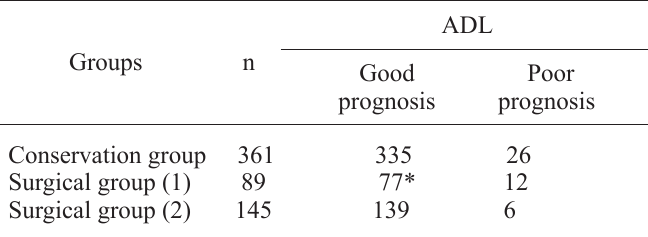
TABLE 1 - Comparison of long-term efficacy in three groups.